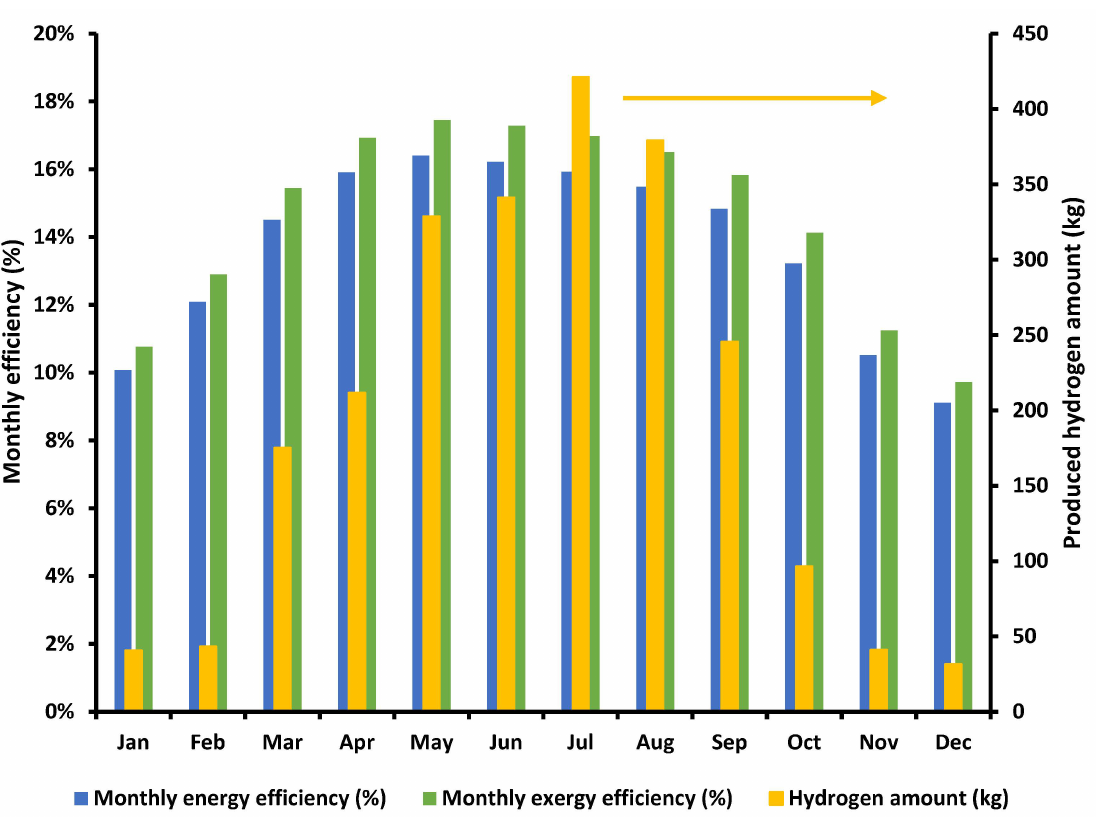
Figure 20. Monthly energy efficiency, exergy efficiency, and hydrogen production amount in